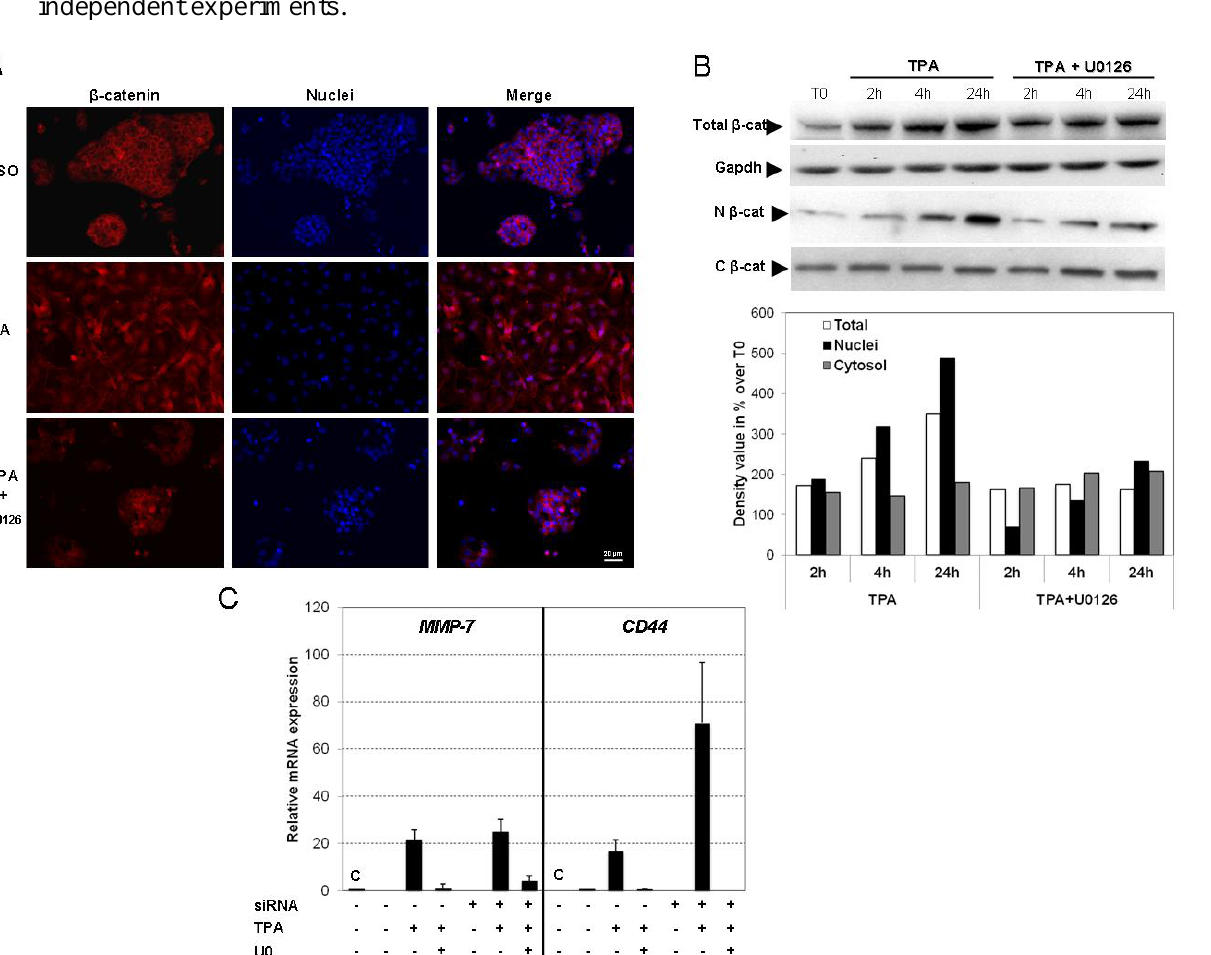
Figure 7. TPA promotes EMT through concomitant activation of the Snaill and Wnt/β-catenin pathways. ( A ) HepG2 cells were grown on coverslips and treated with TPA with or without U0126 for 48 h. After exposure, the cells were fixed and processed for indirect immunofluorescence analysis for the detection of β-catenin (red) and visualization of nuclei (DAPI, blue); ( B ) At indicated time, nuclear (N) and cytosolic (C) fractions were prepared as described in materials and methods, and β-catenin was detected by Western blotting. The semi-quantification of chemiluminescence was performed after the acquisition with a CCD camera. Results are expressed as a percentage of T0-treated cells, designated as 100%. The results are representative of three independent repeats for each experiment; ( C ) Changes in mRNA levels for MMP-7 and CD44 genes upon TPA treatment were assessed by real-time RT-PCR after transfection of control siRNA (C) or Snail siRNA. The HepG2 cells were stimulated with 100 nM TPA, with or without U0126 for 48 h. Relative mRNA expression levels (normalized with respect to gapdh ) were determined and mRNA levels in DMSO-treated cells (untransfected condition) were set to 1. Error bars indicate the means ± SEM of triplicate determinations from three independent